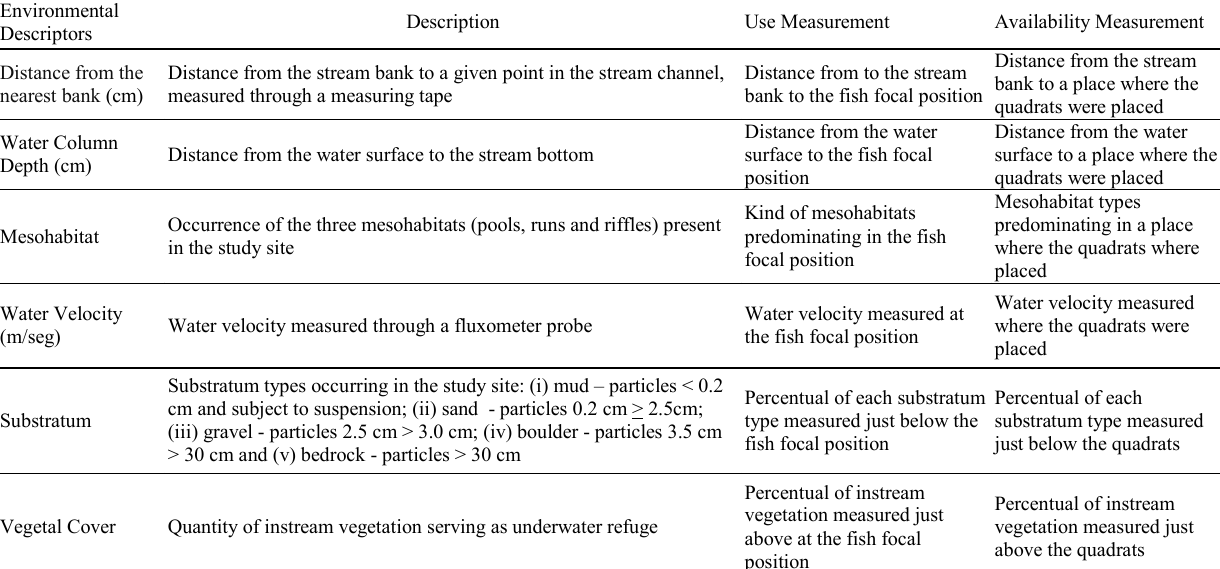
Table 1. Microhabitat descriptors, and their respective measurements for fish use and environmental availability measurements, applied for microhabitat study of Phalloceros harpagos from Mato Grosso stream. Environmental